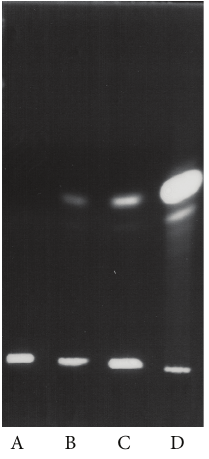
Figure 3: TLC analysis on silicic acid coated plates of the hydrolysis of the fluorescent Bdp-sphingomyelin ( lane A) to Bdp-ceramide ( lane D). Formation of fluorescent ceramide from Bdp-SM (50 𝜇 M final concentration) in 0.5 mM Hepes, 1.8 mM MgCl 2 , and 9mM CaCl 2 ;pH7.4wasmonitoredaftertheadditionof3.3 × 10 7